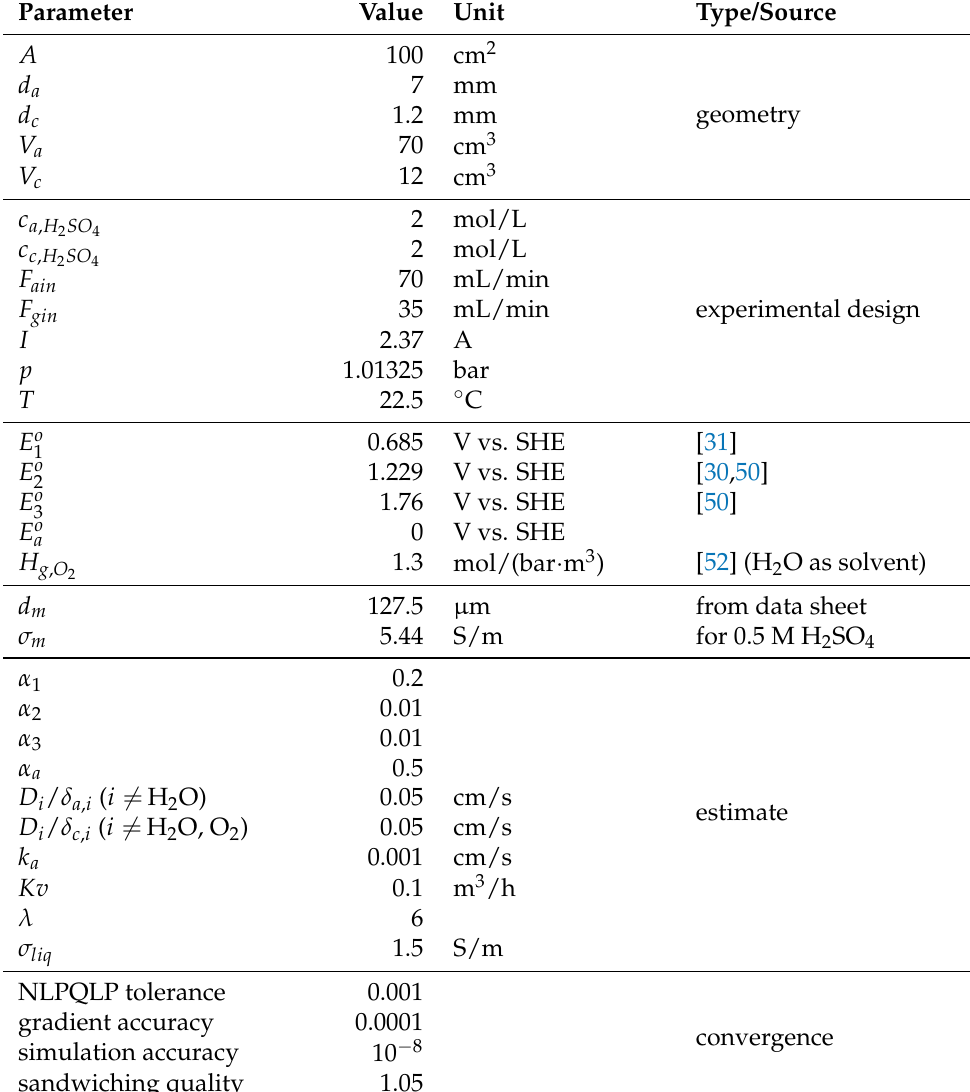
Table 1. Parameter values used in the model adjustment calculations of the electrochemical reactor for determination of the electro-kinetic rate constants k 1 , k 2 and k 3